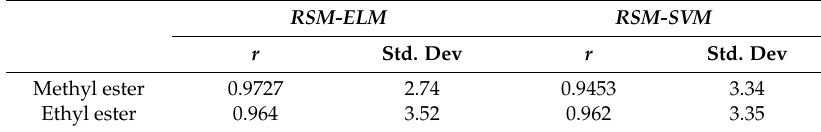
Table 7. The results of the testing stage for both RSM-ELM and RSM-SVM